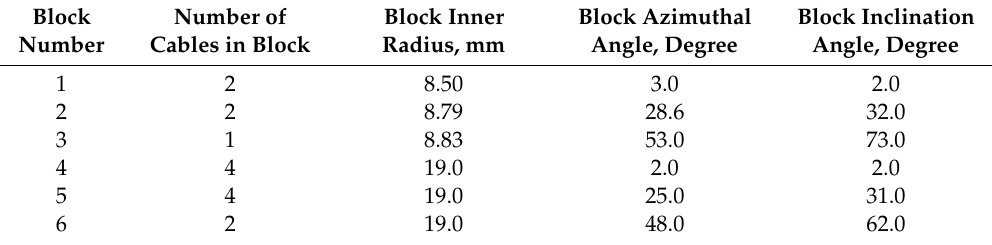
Table 1. Geometrical parameters of coil